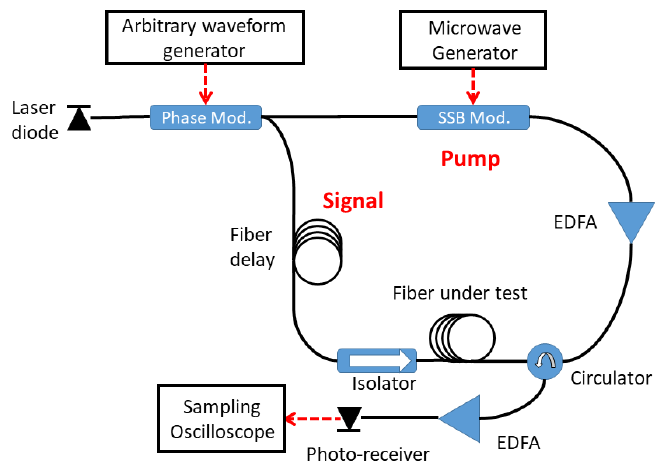
Figure 1. Schematic illustration of a phase-coded Brillouin optical correlation domain setup. EDFA, erbium-doped fiber amplifier; Phase Mod., electro-optic phase modulator; SSB Mod., electro-optic single-sideband modulator.